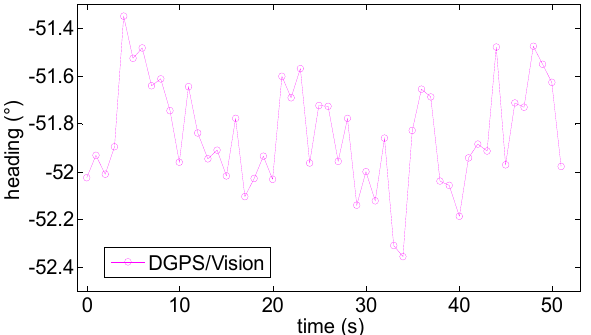
Figure 14. Heading angle as estimated by the DGPS/Vision as a function of time.